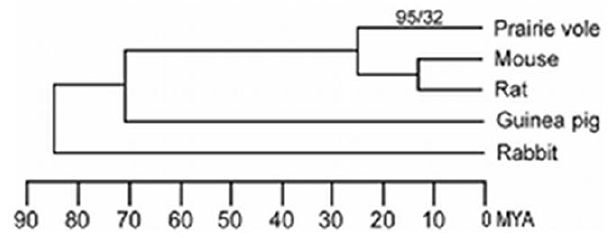
Figure 1. Amino acid substitutions in the prairie vole lineage. The evolutionary relationship of the prairie vole to other rodents and rabbit is illustrated as a phylogenetic tree. Divergence times are represented by the branch lengths of the tree based on [39,40]. The numbers above the terminal branch leading to the prairie vole represent the number of conservative/radical amino acid substitutions in the behaviorally-relevant proteins that were inferred by parsimony to have occurred in that lineage and unique to the prairie vole. MYA refers to millions of years ago.